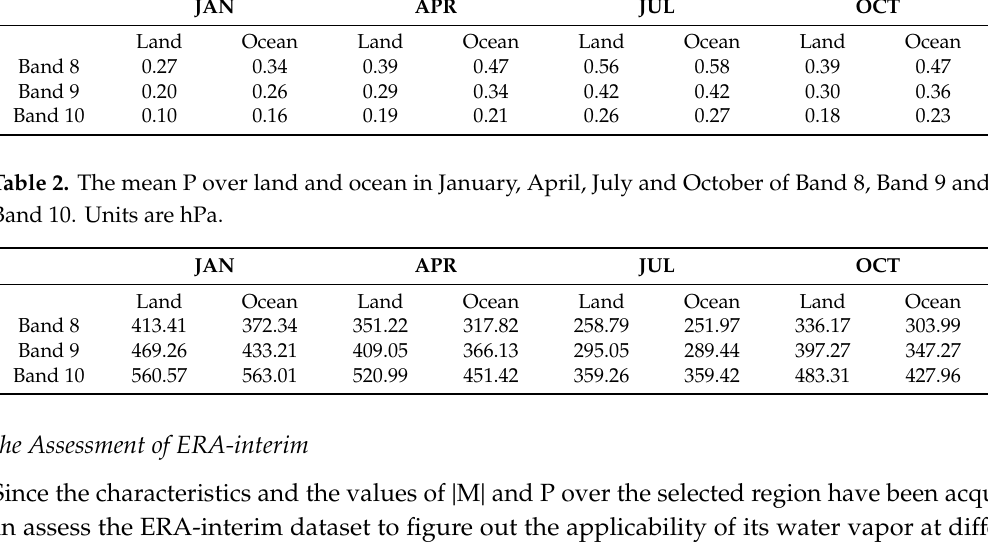
Table 1. The mean | M | over land and ocean in January, April, July and October of Band 8, Band 9 and Table 1. The mean |M| over land and ocean in January, April, July and October of Band 8, Band 9 Band 10. Units are K / log(kg / kg). and Band 10. Units are K/log(kg/kg).